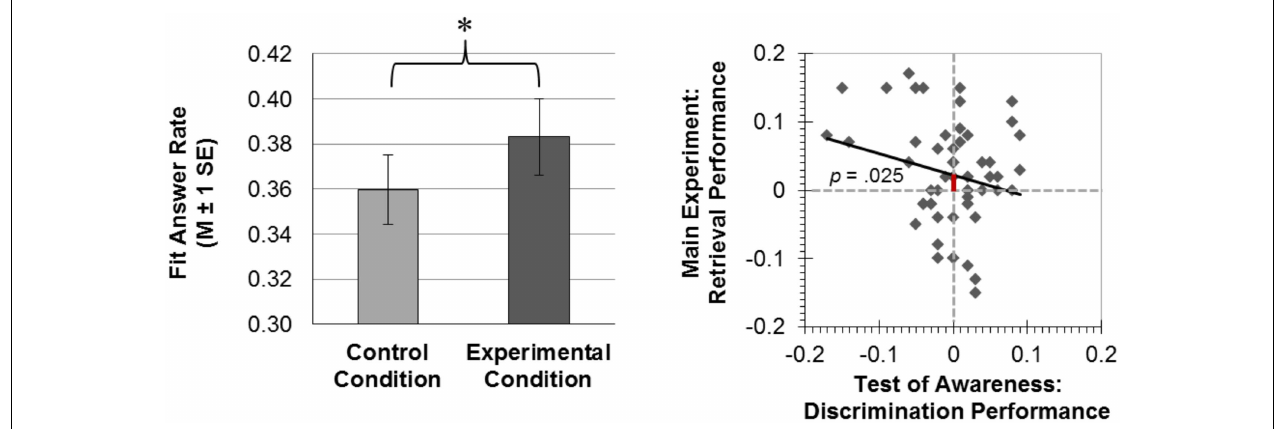
regressed the discrimination performance in the test of awareness [(hits + correct rejections) − (false alarms + misses)] onto the rate of fit responses given to episodically related (experimental condition) minus unrelated (control condition) test words.The y -axis intercept was significantly greater than zero.This indicates that the integration of events across consciousness levels was significant, when conscious discrimination performance was